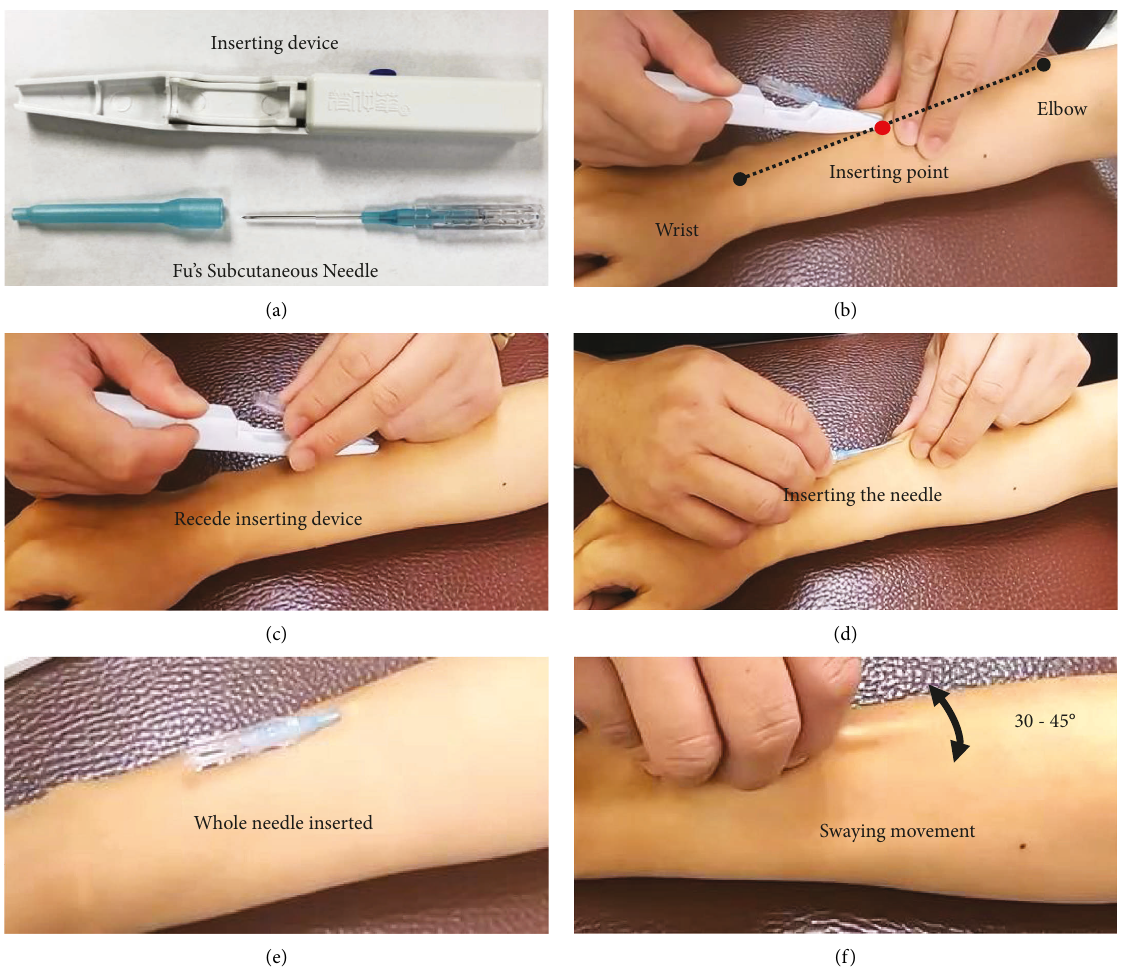
Figure 3: Procedure of Fu’s subcutaneous needling. FSN was performed with a disposable Fu’s subcutaneous needle (bottom) and inserting device (top) (a). The inserting point was on the midpoint between wrist and the elbow of the affected forearm (b). Holding the Fu’s subcutaneous needle and receding inserting device (c). Inserting the needle into subcutaneous layer (d) until the whole needle is inserted (e). Swaying the needle in a 30-to-45-degree movement